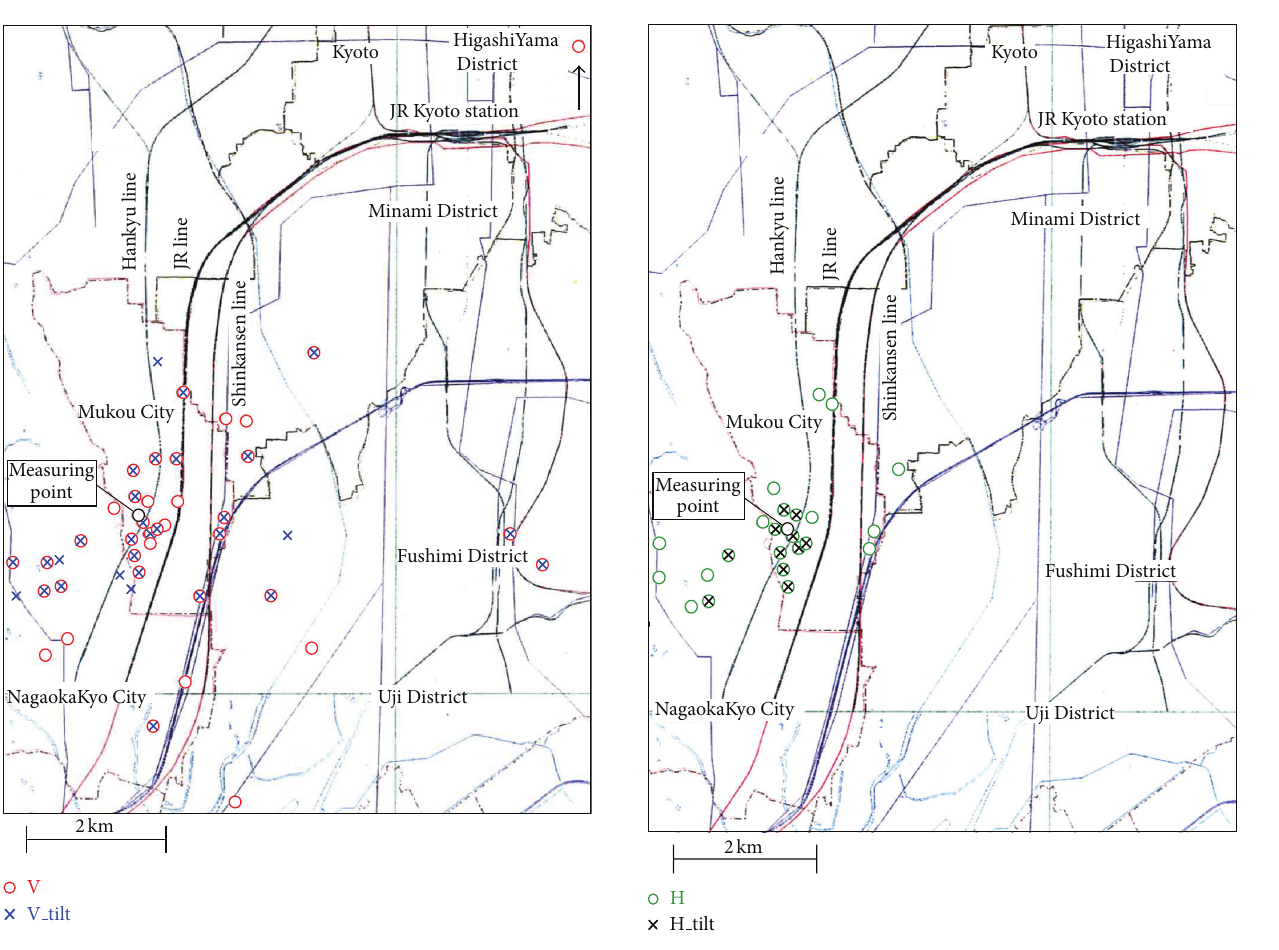
Figure 11: Distribution of IBSs when IRBS antennas are H antennas and H tilt antennas.